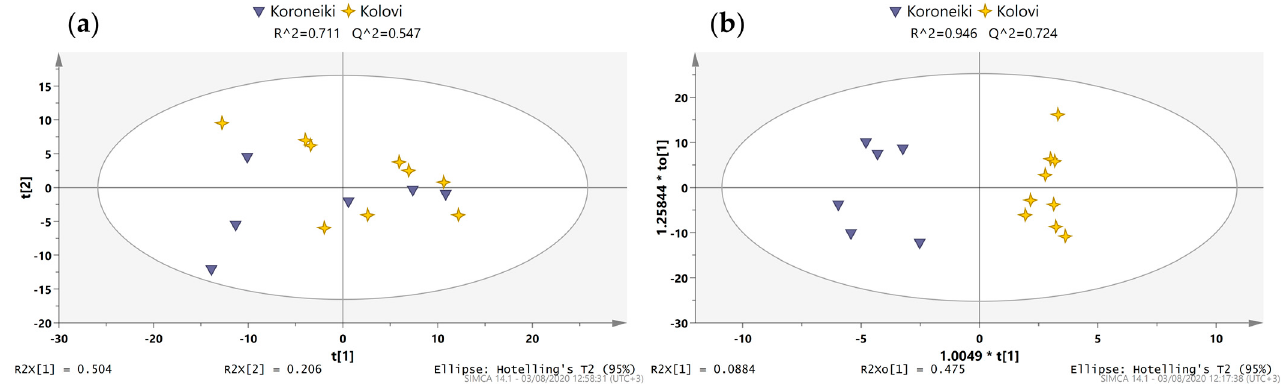
Figure 3. ( a ) PCA scores scatter plot of PC1 and PC2 with the Greek samples examining botanical origin; ( b ) respective OPLS-DA scores scatter plot.